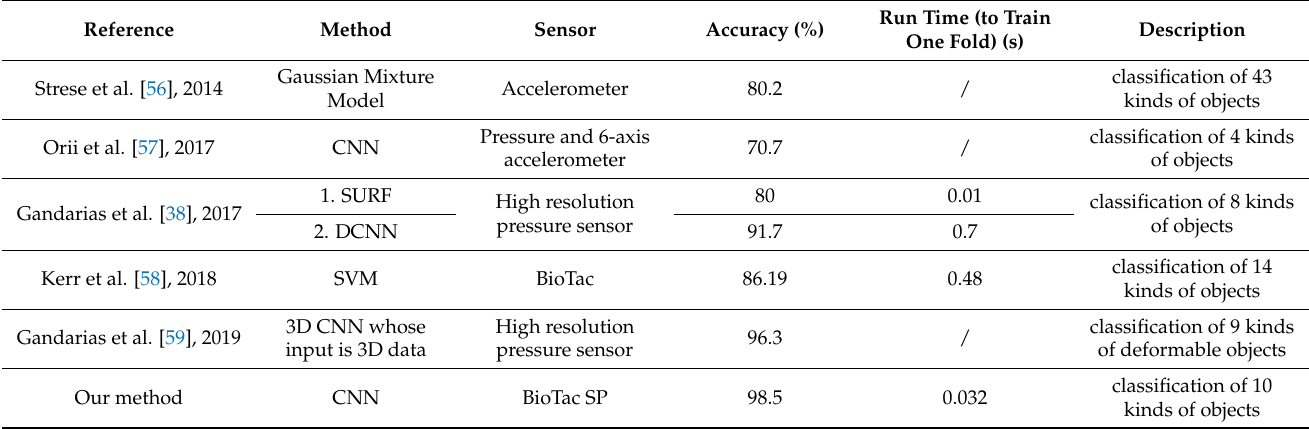
Table 5. Comparisons of texture recognition